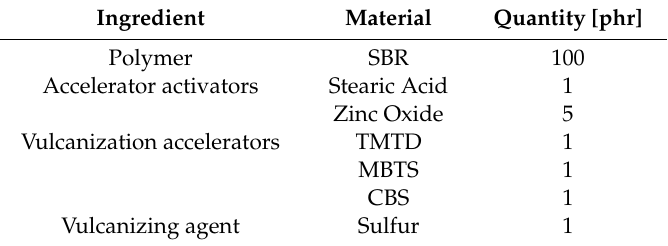
Table 1. Compounding formulation of the thick sample for vulcanization evaluation.